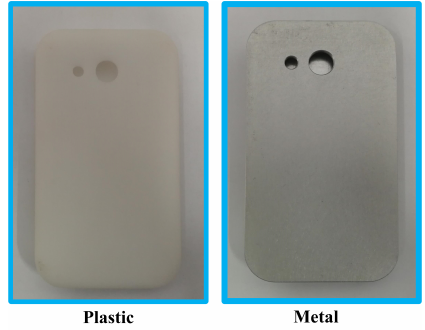
Figure 13. Two types of materials for the